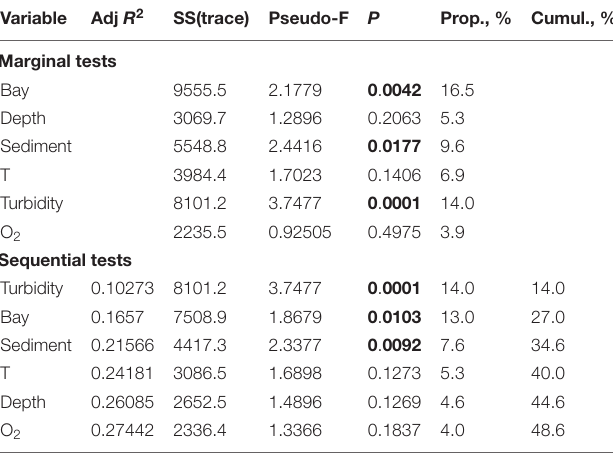
TABLE 5 | The distance based linear modeling (DistLM) procedure using forward selection, examining the relationship between environmental variables and macrofauna distribution patterns in three fjords with intensive run-off (Blagopoluchiya, Tsivolki and